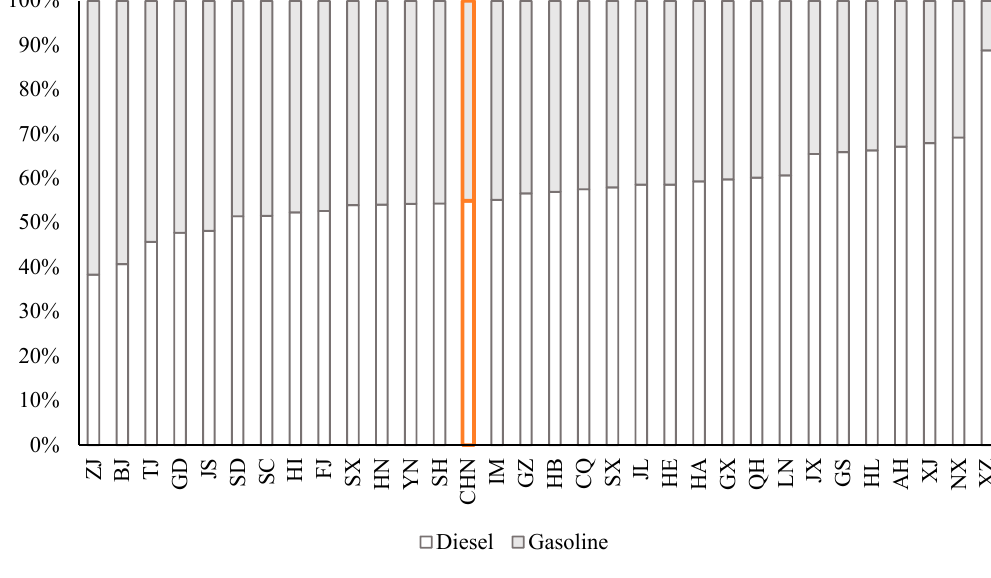
Figure 6. Provincial projections of fuel consumption in 2035.